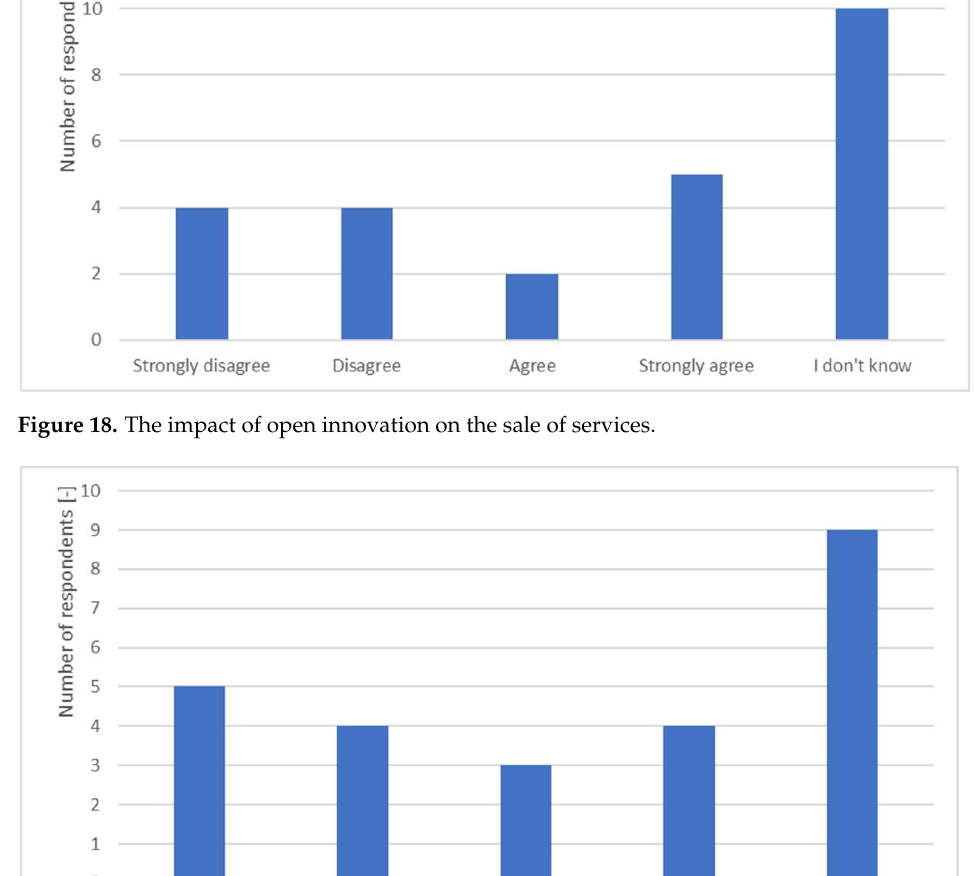
Figure 19. The impact of open innovation on acquiring more diverse customers.